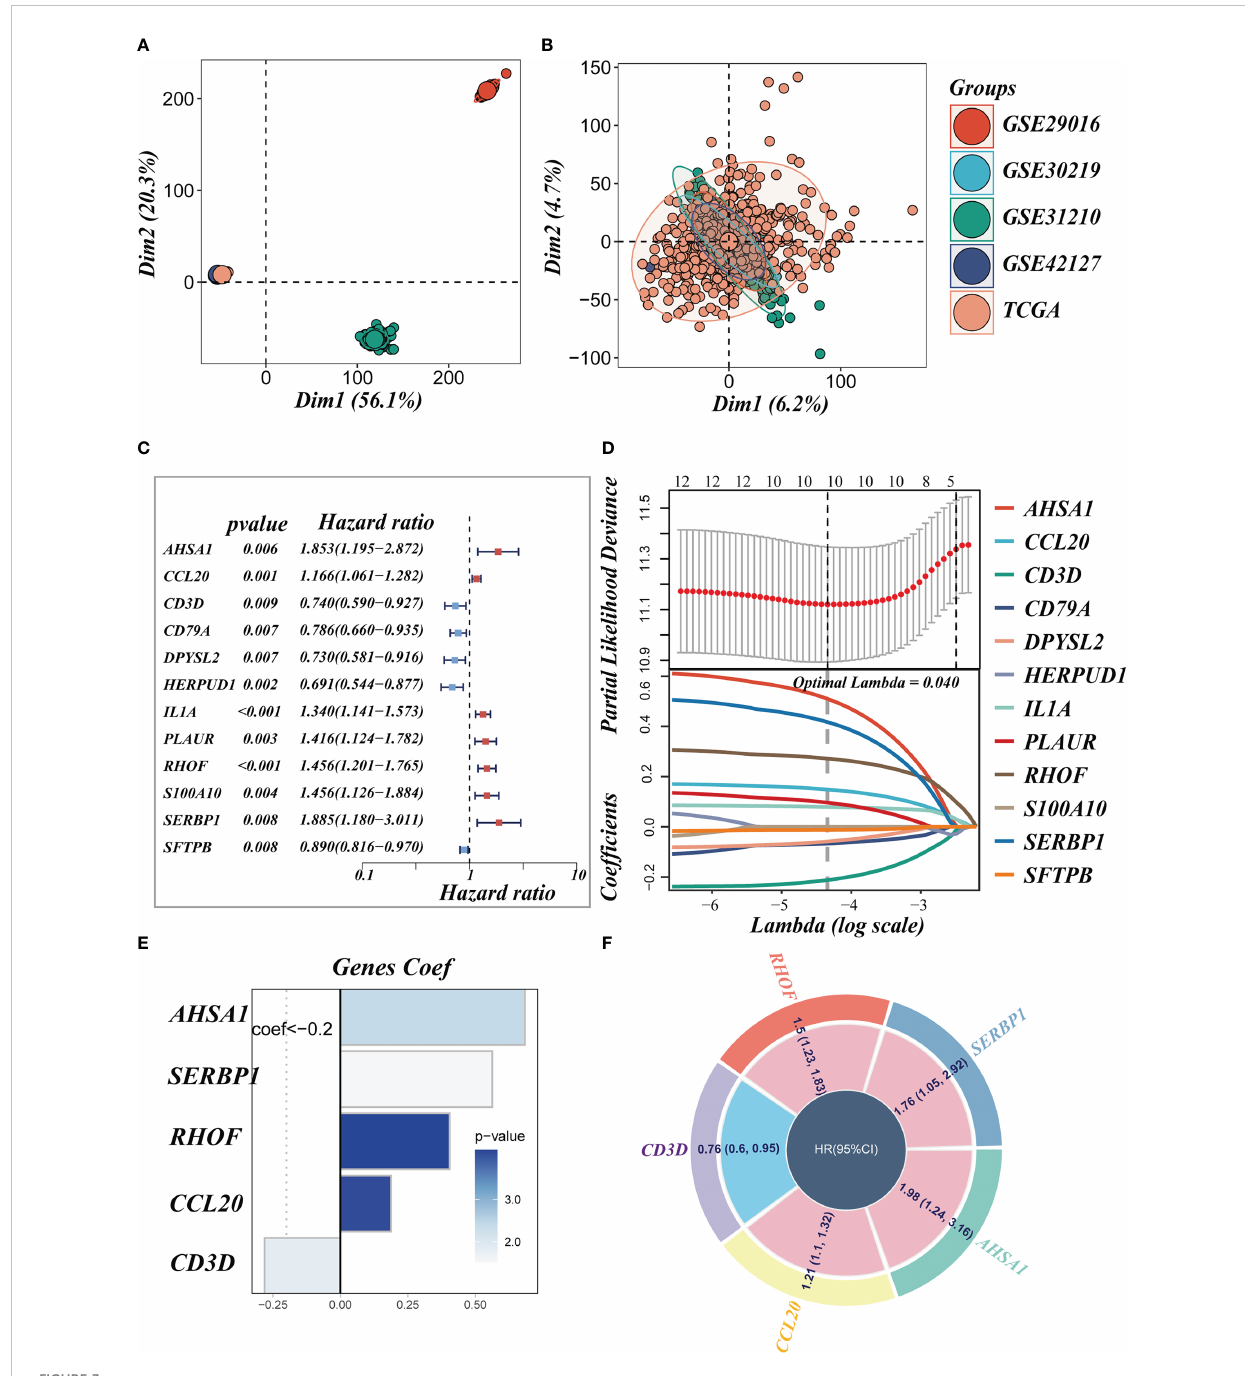
FIGURE 3 Construction of the signature. (A, B) PCA plots before and after removal of batch effects for 5 datasets. (C) A forest plot presents prognostic associated LMRGs. (D) Eleven prognostic LMRGs were included in the LASSO regression analysis to screen the most important model genes. (E, F) Coef fi cients for model genes as well as HR values for model